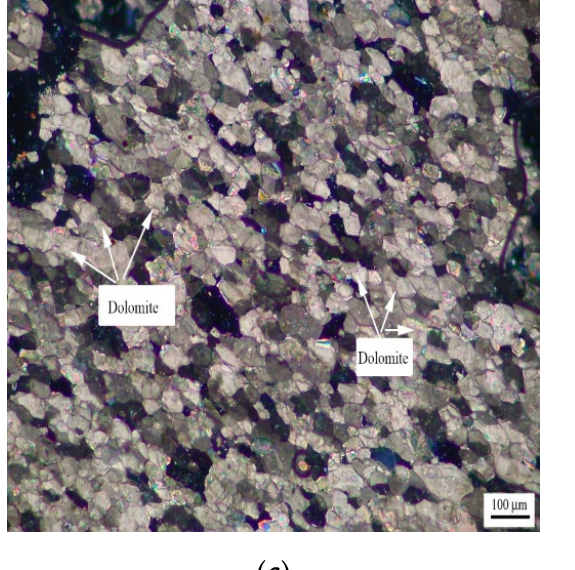
Figure 5. Distribution of dolomites in Ordovician rocks ( a ) ZC, ( b ) JF, ( c ) DH-1, and ( d ) DH-2.